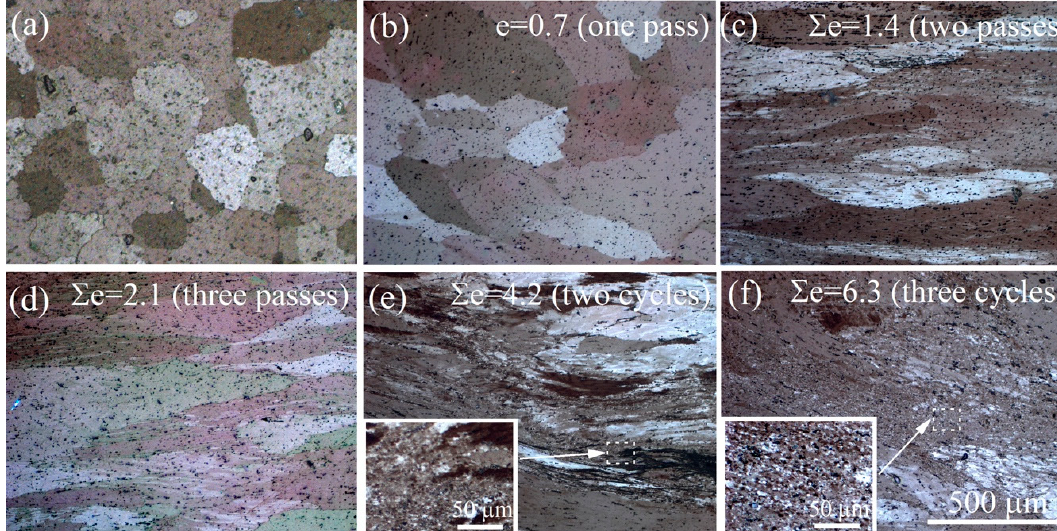
Figure 3. Evolution of the grain structure in the near-surface layer during isothermal multidirectional forging at 350 ◦ C: ( a ) as-cast structure; ( b ) the first pass along the z-axis; ( c ) the second pass along the y-axis; ( d ) the third pass along the x-axis; ( e ) two cycles with ∑ e = 4.2; ( f ) three cycles with ∑ e = 6.3; inserts in the ( e ) and ( f ) grain structures of the local places at a higher magnification; polarized light, optical microscope.